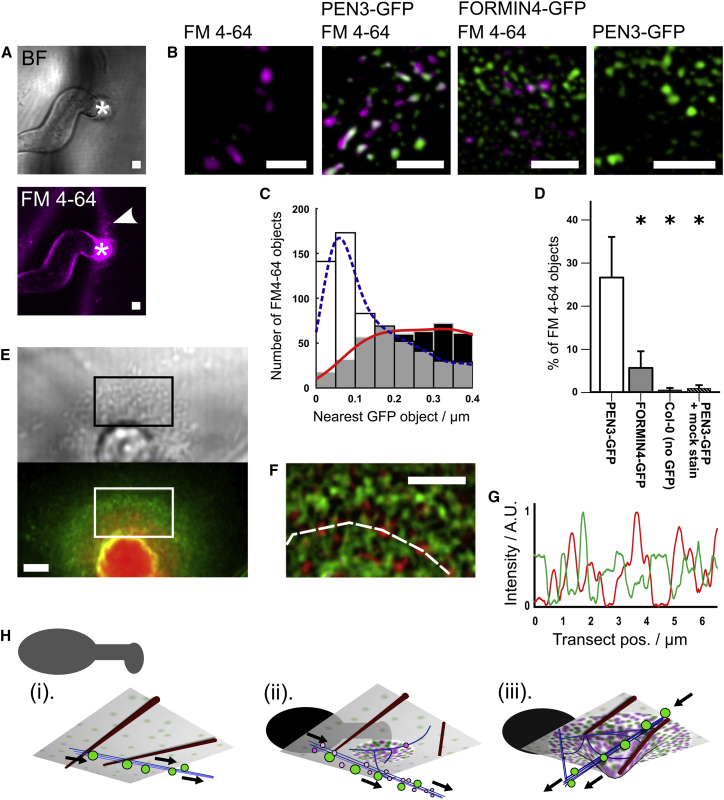
FORMIN4 Transport and Meso-localization Are Distinct from PEN3(A) Bright field image of Bgh appressorial germ tube contact site with CWA (indicated by asterisk) and endosomal network (EN) compartments (indicated by white arrowhead) visualized by FM4-64 uptake (magenta). The scale bars represent 2 μm. See also Figure S4.(B) Laplacian of Gaussian (LoG) filtered images of simultaneous detection of FM4-64-labeled EN compartments (magenta) and GFP expression (green) in wild-type (Col-0), PEN3-GFP, FORMIN4-GFP, and mock-treated PEN3-GFP cells. Mock treatment of PEN3-GFP resulted in no visible EN vesicles in the FM4-64 detection wavelength, and FM4-64-treated wild-type samples showed no signal above background within the GFP excitation/emission channel. The scale bars represent 2 μm.(C) Distance-based quantification of co-localization between FM4-64-labeled compartments and GFP-labeled objects shows that a peak sub-population of PEN3-GFP objects, but not FORMIN4-GFP objects, coincide at distances less than the diffraction limit of the microscope. Histogram represents centroid distance of PEN3-GFP compartments to EN compartments (white bars and blue Gaussian kernel regression) and FORMIN4-GFP to EN compartments (black bars and red Gaussian kernel regression). Grey areas show histogram overlap.(D) PEN3-GFP co-labels 26.6% (±9.5%) of the EN objects, whereas only 5.6% (±3.9%) of the EN is within equivalent distances to FORMIN4-GFP objects. Asterisk indicates a p value evaluated by pairwise comparison with Student’s t test of <0.001. Error bars show SD.(E) Co-expressed FORMIN4-tdTomato (red) and PEN3-GFP (green) at the plasma membrane in the region of a CWA. See also Figure S4. The scale bar represents 2 μm.(F) Bandpass phase-frequency filtering highlights the local enrichment of FORMIN4-tdTomato and PEN3-GFP plasma membrane domains (area enlarged from white box in D) showing tessellation of FORMIN4 and PEN3 enrichments. The scale bar represents 2 μm.(G) Amplitude of transect taken from the dashed line in (E). Peaks of FORMIN4-tdTomato (red) do not coincide with peaks of PEN3-GFP (green).(H) Model proposing a sequence of events leading to positional feedback during an immune response. The zero time point (i) shows wide PM distribution of PEN3 (green patches) and sub-cortical PEN3-containing EN compartments (green spheres) mobilized on the actin network (blue lines; microtubules are represented by brown rods). Arrowheads indicate the unidirectional flow of the local cytoplasmic stream. Local perception of the appressorium (background silhouette) is about to initiate. By four hours (ii) post-perception, FORMIN4-containing vesicles (magenta spheres) are present within the cytoplasmic stream and content is arriving at the nascent response zone of the PM in an actin-dependent process. By forty-eight hours (iii), a fully developed CWA has intercepted the penetration attempt and has accumulated distinct PM content, including stable FORMIN4. The cytoskeleton accommodates and engages with the new PM topography, in part through the earlier actin-dependent deposition of PM proteins.